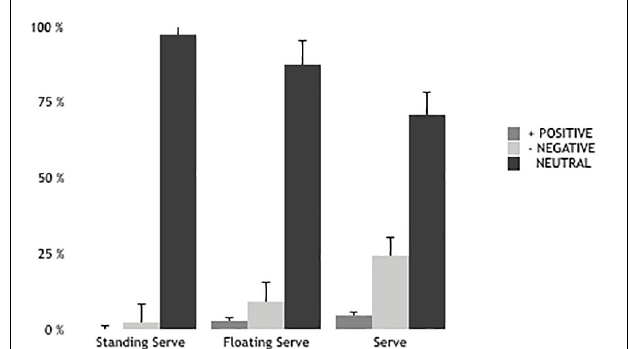
FIGURE 1 | Effectiveness of serve in men.